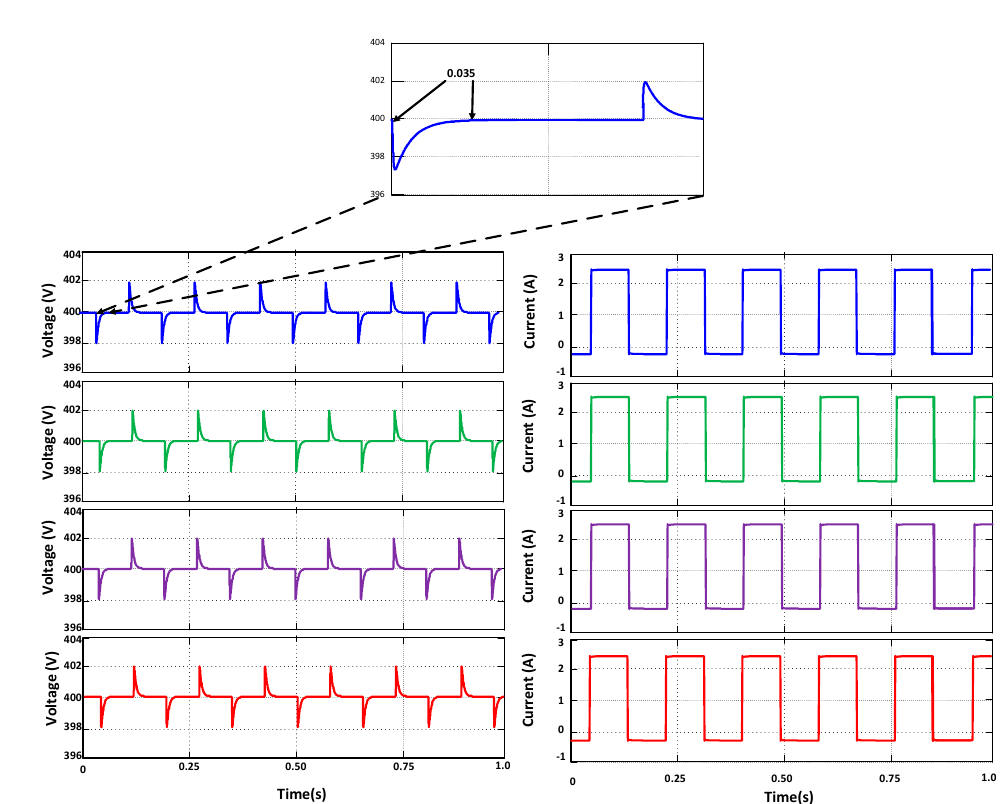
Figure 13. Current and voltage waveforms response of the existing technique [13] with disturbance signal.